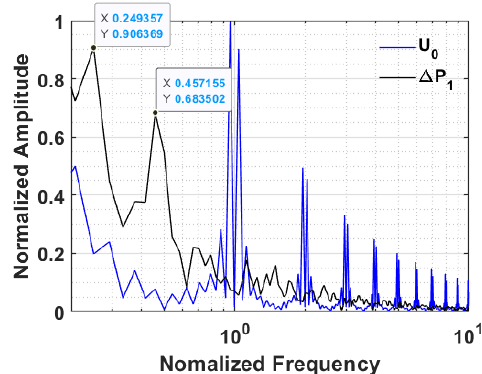
Figure 8. Frequency response of the upper region pressure drop and velocity signals for the fluidized bed of the hydrophobic nanosilica.